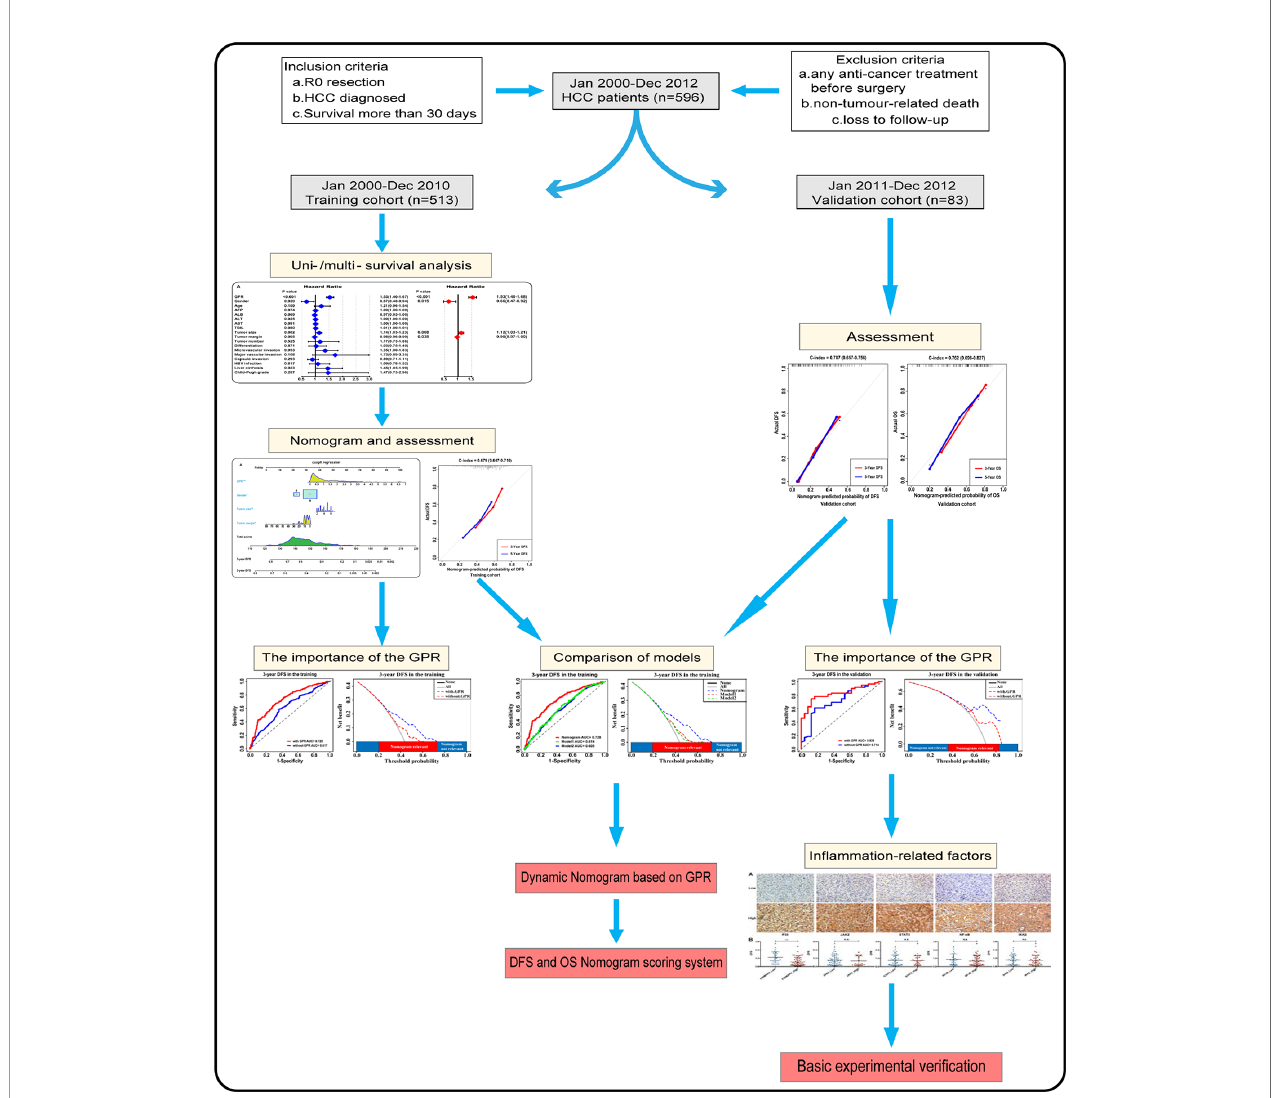
FIGURE 1 | Flowchart of the analysis. GPR, gamma ‐ glutamyl transpeptidase ‐ to ‐ platelet ratio; HCC, hepatocellular